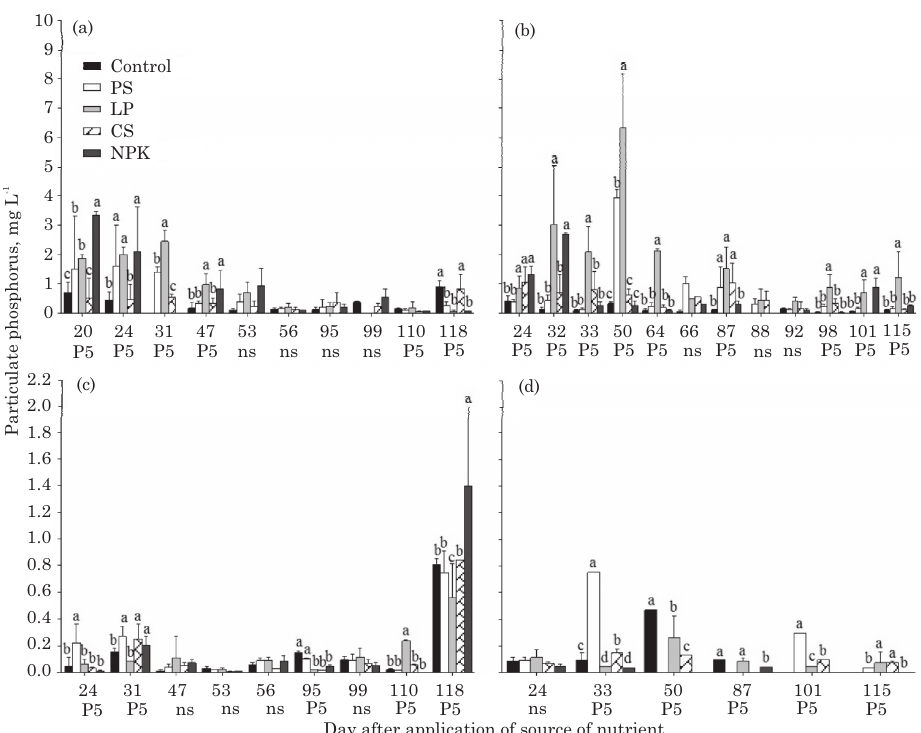
Figure 4. Particulate phosphorus content in the runoff solution on the soil surface from black oat (a) and maize (b); and in the leached solution from black oat (c) and maize (d), in a Typic Hapludalf treated with nutrient sources. P5: significant at 5 % probability by the Scott-Knott test; ns: not significant at 5 % probability.